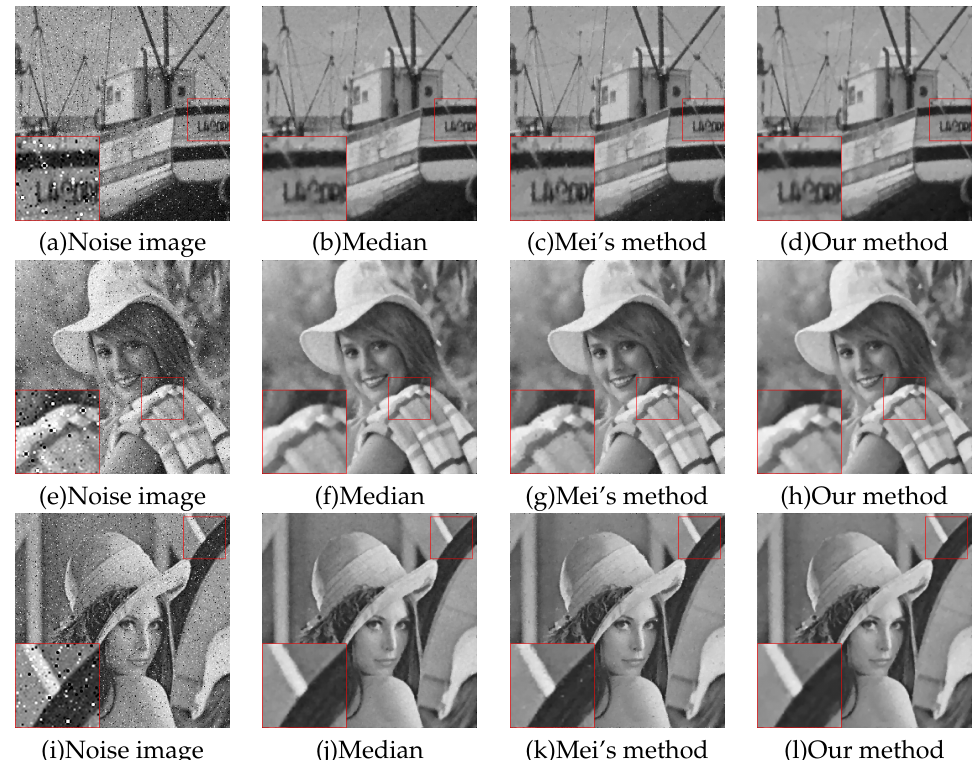
Figure 4. Denoising results of three methods at η = 0.02.